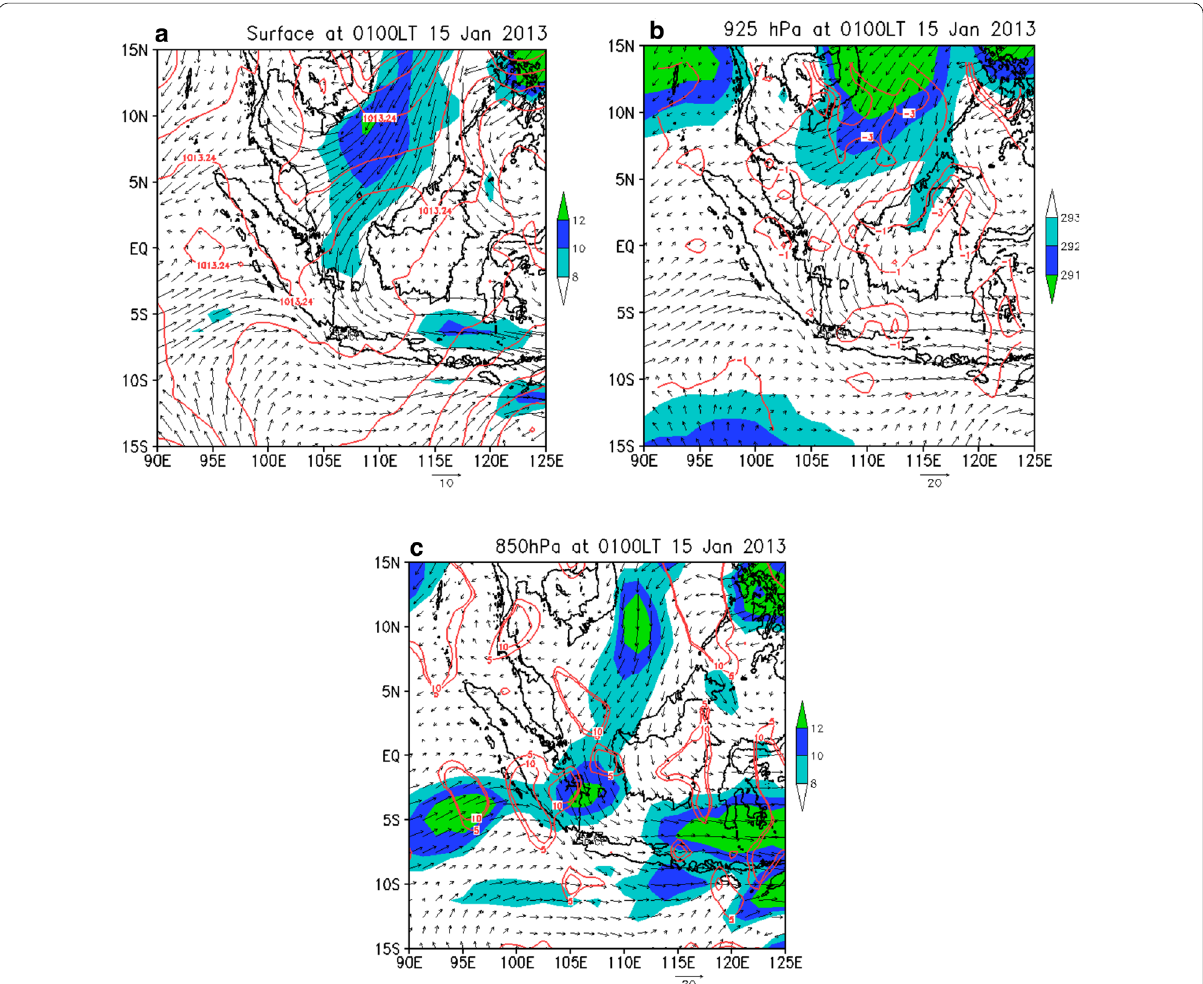
Fig. 11 JRA55 reanalysis of a horizontal wind vectors (ms − 1 , speed also shaded) and pressure (hPa, contours) at mean sea level, b horizontal wind vectors (ms − 1 ), air temperature (K, shaded), temperature advection (10 − 5 Ks − 1 , contours) at 925-hPa and c horizontal wind vectors (ms − 1 , shaded), temperature advection (10 − 5 Ks − 1 , contours) at 850-hPa during the first MCS